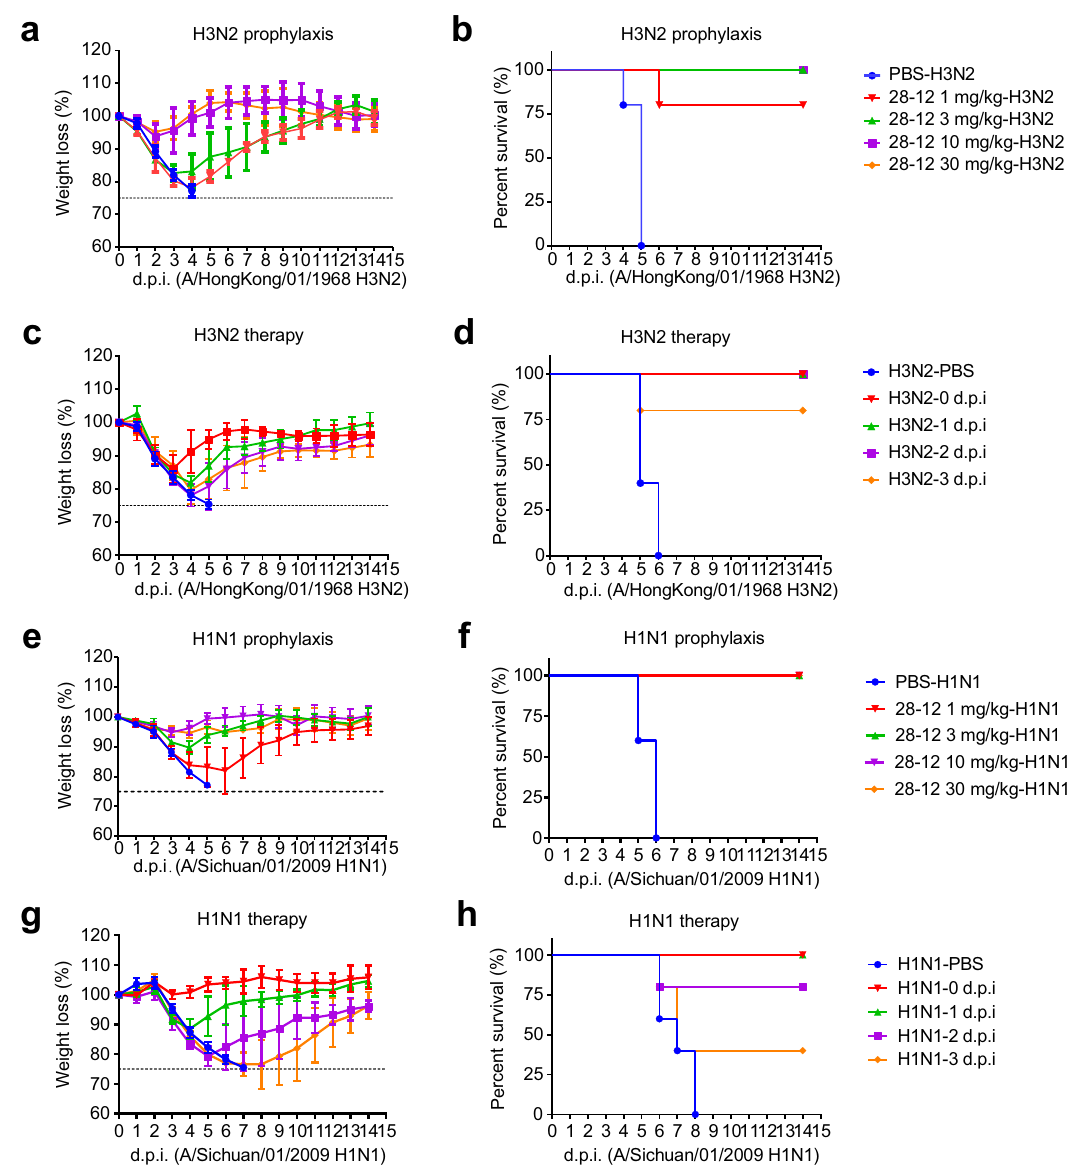
Fig. 3 Prophylactic and therapeutic ef fi cacy of 28-12 in mice. a , b Prophylactic ef fi cacy of 28-12 against a lethal challenge with 68/HK H3. Mice were treated with 30, 10, 3 or 1 mg/kg 28-12 or PBS 24 h before intranasal inoculation with the in fl uenza virus. The weight loss and survival data were collected daily for 14 days after inoculation (day 0). n = 5. c , d Therapeutic ef fi cacy of 28-12 against a lethal challenge with 68/HK H3. Mice were treated with PBS buffer (at day 0) or 25 mg/kg 28-12 immediately after or 1, 2, or 3 days after intranasal inoculation with in fl uenza virus. The weight loss and survival data were collected daily for 14 days after inoculation with viruses (day 0). n = 5. e , f Prophylactic ef fi cacy of 28-12 against a lethal challenge with SC/09 H1. n = 5. g , h Therapeutic ef fi cacy of 28-12 (25 mg/kg) against a lethal challenge with SC/09 H1. n = 5. Error bars represent the mean ± S.D ( a , c , e , g ). All data show a representative experiment from two independent Supplementary Table 3). Overall, the atom-to-atom contact numbers between 28-12 and H1 or H3 helix A are 144 and 191, respectively (Fig. 4n and Supplementary Tables 4 and 5). It is worth noting that the H3 residue N49 HA2 contributes much more contact numbers (32) with 28-12 than the substitute residues T49 HA2 (10) of H1 (Fig. 4n and Supplementary Tables 4 and 5). The site-directed mutational binding assay also con fi rmed that N49 HA2 is critical for H3 HA binding to 28-12, while T49A HA2 did not affect the binding between H1 HA and 28-12 (Fig. 4o, p). Collectively, these results indicate that the epitopes within helix A are critical for 28-12 to react with both H1 and H3, and form more interactions with H3.